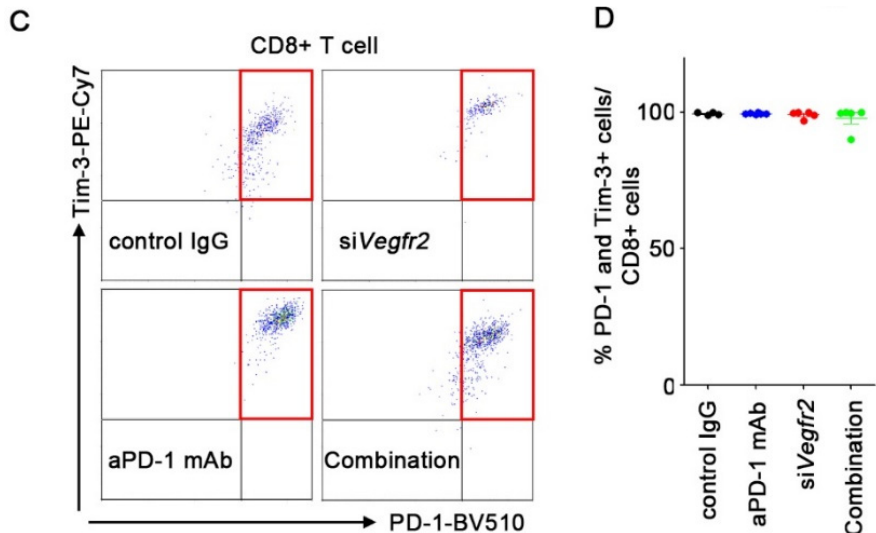
Figure 5. Effect of combination therapy on T cell infiltrations in MC38 tumors. MC38 tumor-bearing mice were treated on days 5, 8, and 12, and tumors were harvested on day 13 for flow cytometric analysis. ( A ) Representative flow plots of CD8+ T cells from MC38 tumors. ( B ) Frequency of CD8+ T cells (CD45+CD3+CD8+) in CD45+ cells in MC38 tumors. Mean ± S.E. ( n = 8). * p < 0.05 and ** p < 0.01 determined using one-way ANOVA followed by Tukey’s test. ( C ) Representative flow plots of PD-1 and Tim-3 fluorescence intensities on isolated CD8+ T cells from MC38 tumors. ( D ) Frequency of PD-1+Tim-3+ cells in CD8+ T cells in MC38 tumors. Mean ± S.E. ( n = 6).